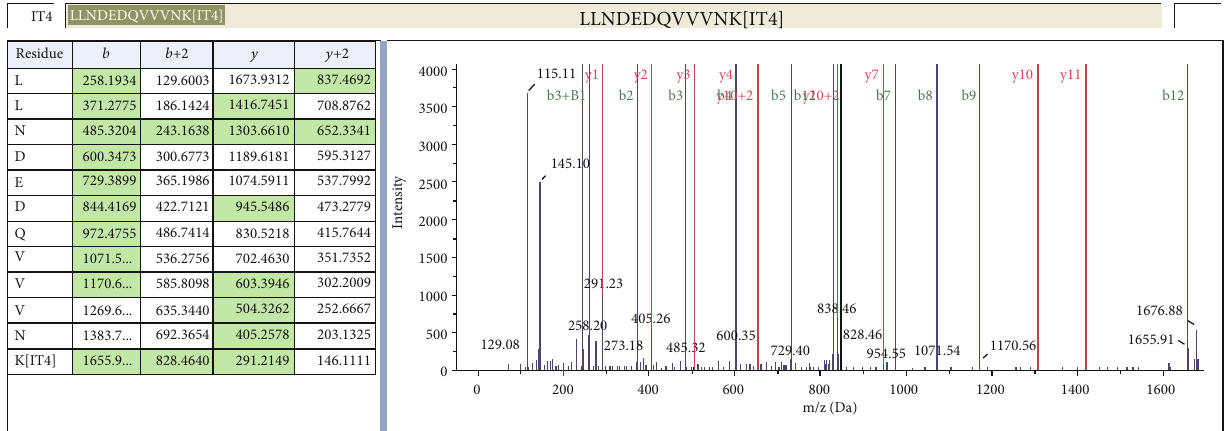
Figure 1: CTNNB1 expression is upregulated during the malignant transformation of hESCs. MS/MS spectra of iTRAQ-labeled peptides from CTNNB1. (a) The relative peak heights of iTRAQ labels. (b) A representative tandem mass spectrum of a peptide in each protein. Reporter ions in (a) demonstrate examples of equal, low, and high protein levels in normal and aberrant ch HES-3 cells. Normal, SIMP, COMP, and NTERA-2 cells are labeled as 114, 115, 116, and 117, respectively. The x -axis of a mass spectrum represents the correlation between the mass of a given ion and the number of elementary charges. This is represented as the IUPAC standard m/z to denote the quantity generated by dividing the mass of an ion by the uni fi ed atomic mass unit and its charge number (positive absolute value). Data are represented in Dalton (Da) as the unit of mass. The y -axis of a mass spectrum represents the signal intensity of